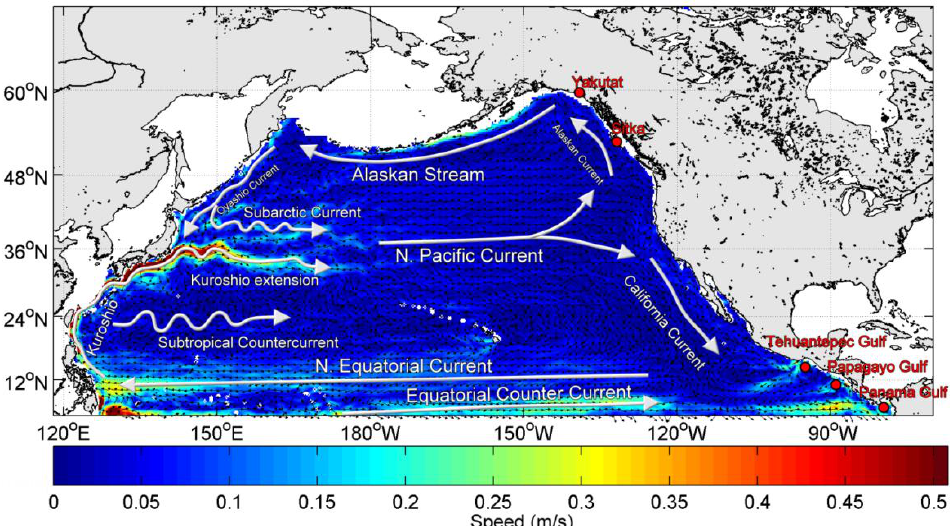
Figure 1. Schematic current patterns in the North Pacific. Geostrophic currents are calculated from altimeter absolute dynamic topography data and averaged over a period from 1992 to 2012. Background color is the speed of geostrophic